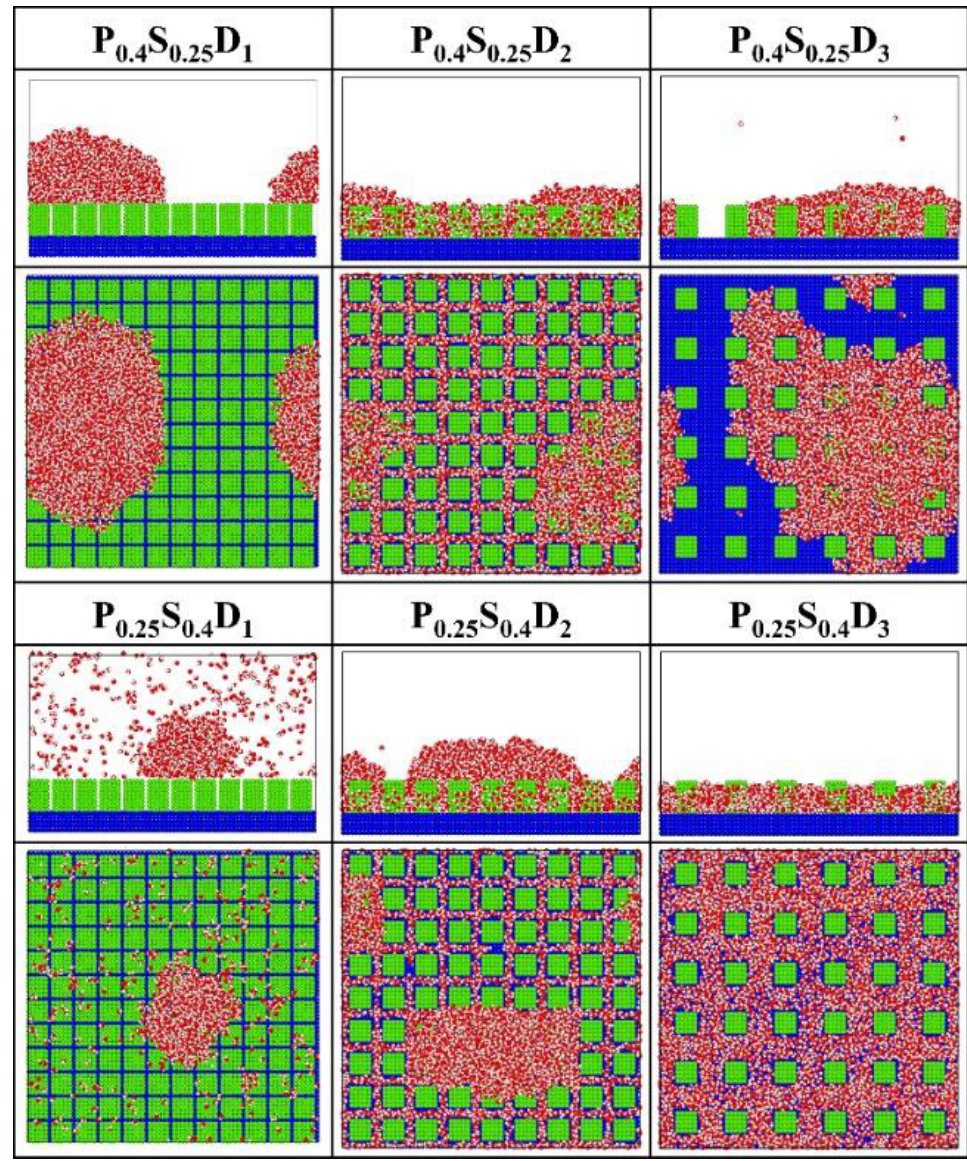
Figure 7. The snapshot of the condensate formed on the surfaces with hybrid wettability at the end of the